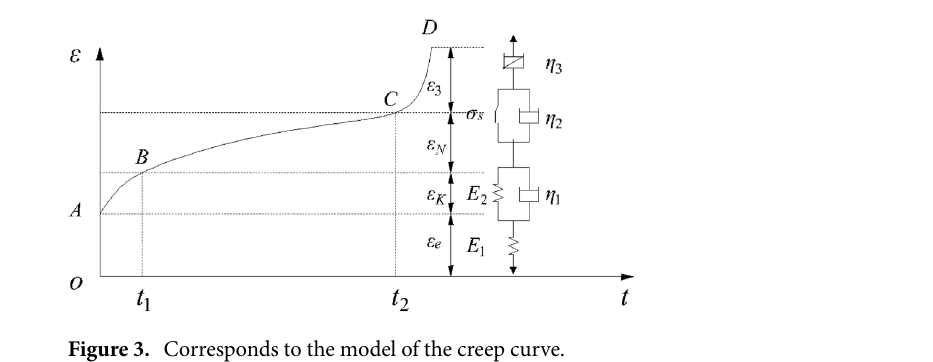
Figure 3. Corresponds to the model of the creep